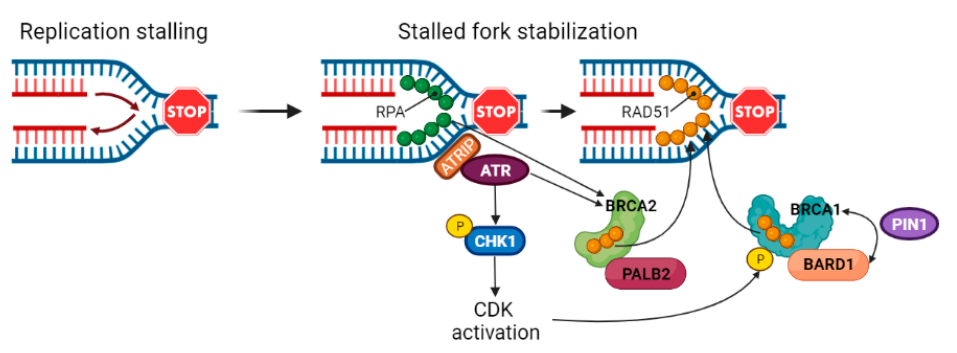
Figure 4. Stalled fork stabilization. During DNA duplication, replication forks often encounter obstacles that can lead to genotoxic fork stalling. Stalled forks are characterized by exposed DNA ends, which can be degraded by various cellular nucleases. Under replication stress, extensive ssDNA is readily protected and stabilised by RPA. ATRIP binding to RPA–ssDNA promotes ATR localization. ATR phosphorylates RPA and CHK1, leading to CDK activation. Both ATR and RPA promote PALB2 and BRCA2 translocation to stalled replication forks, while CDK phosphorylates BRCA1. The RPA– ssDNA complex is displaced by the RAD51 protein. RAD51 loading and stabilization are enhanced by the BRCA2/PALB2 complex as well as by the BRCA1–BARD1 complex. The phosphorylation- directed prolyl isomerase PIN1 enhances BRCA1–BARD1 interaction with RAD51. Stable RAD51 nucleoprotein filaments then mediate replication fork